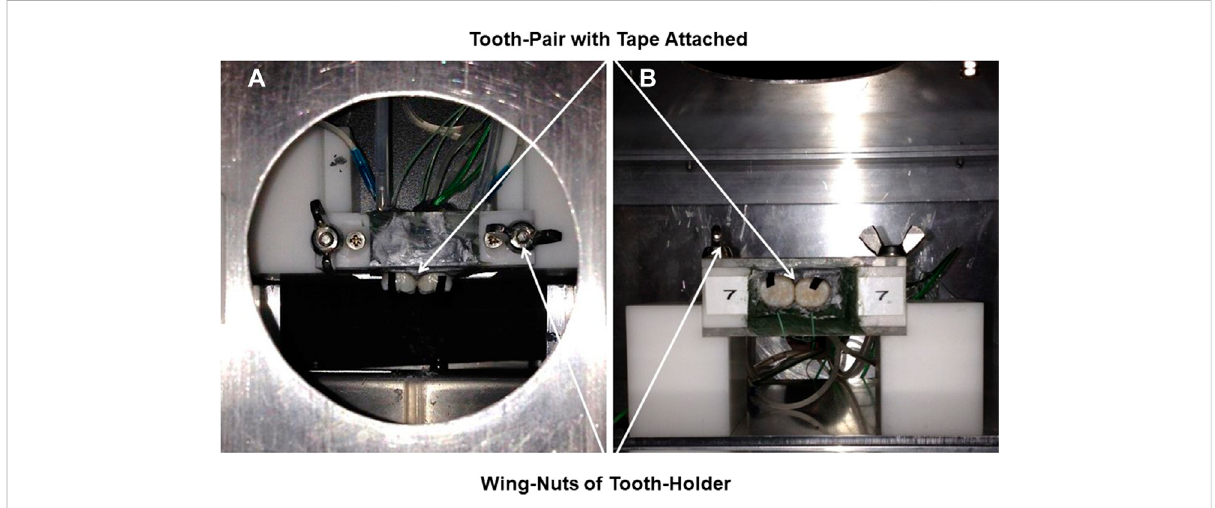
FIGURE 2 (A) :Verticaland (B) :horizontalclose-upofthetooth-pairunitsecuredbywing-nutstotherigid-standinthealuminiumcube.3MScotchSuper 33+ Black Vinyl Electrical Tape attached to tooth-surface for emissivity-reference-point of